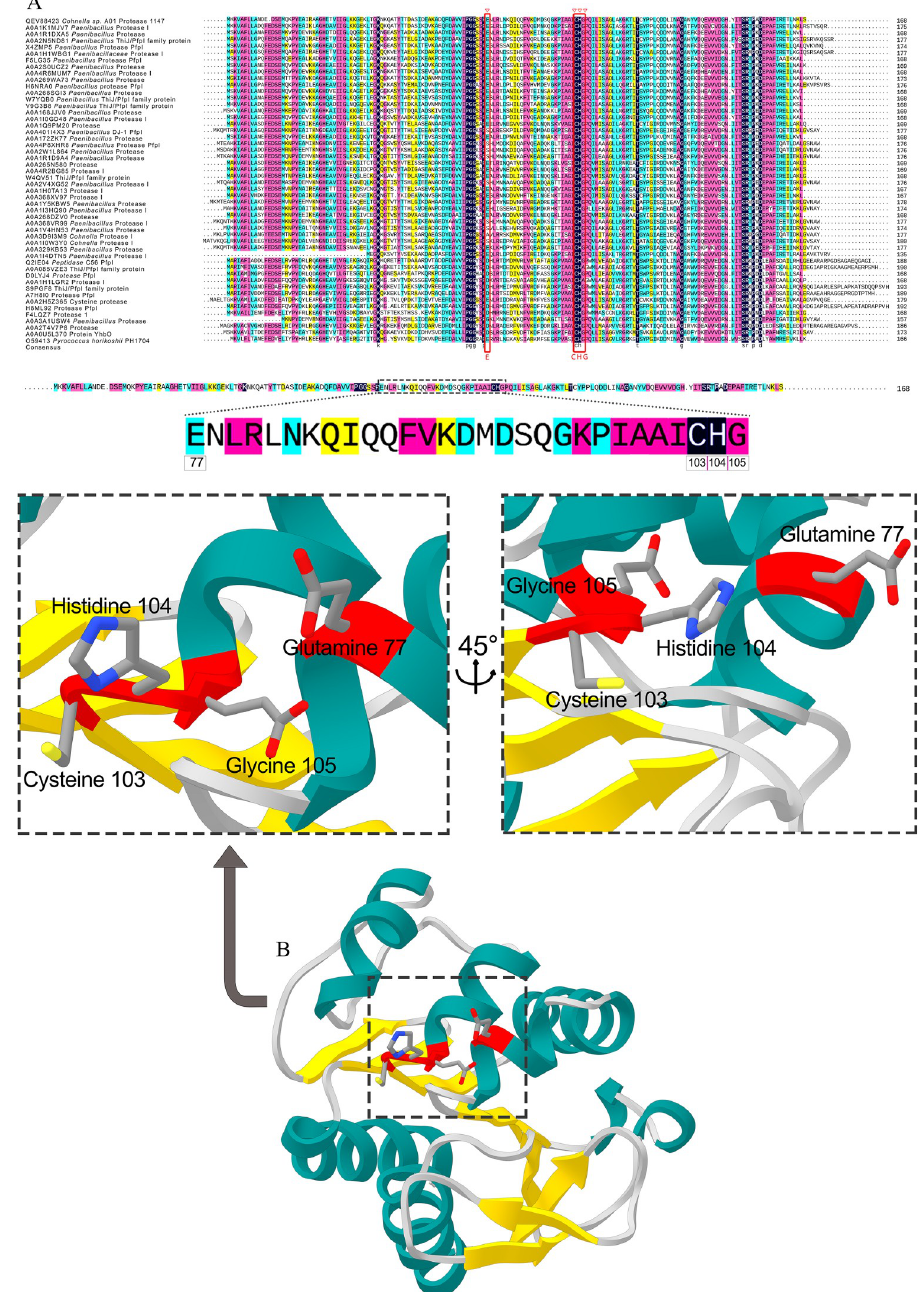
Fig 2. Conserved sequence of protease 1447. (A) Protein sequence alignment of the protease 1147 and several closely related sequences. The r over residues in the boxed regions represent the conserved catalytic tetrad. (B) The amino acids involved in the catalytic tetrad of protease 1147 (Glu 77 –Cys 103 –His 104 –Gly 105 ) are marked in red ribbon sticks. The accession number of the sequences are